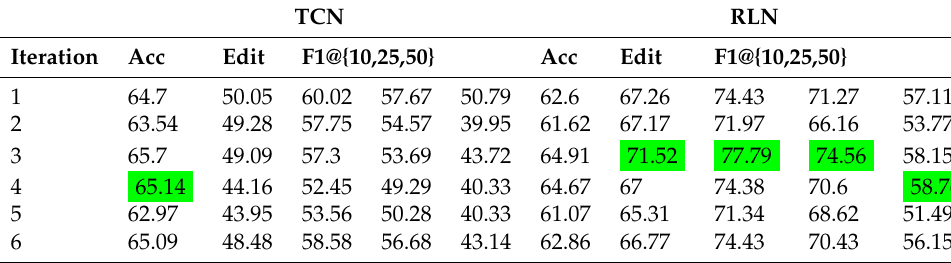
Table 8. RL-SSI in the Tea context.